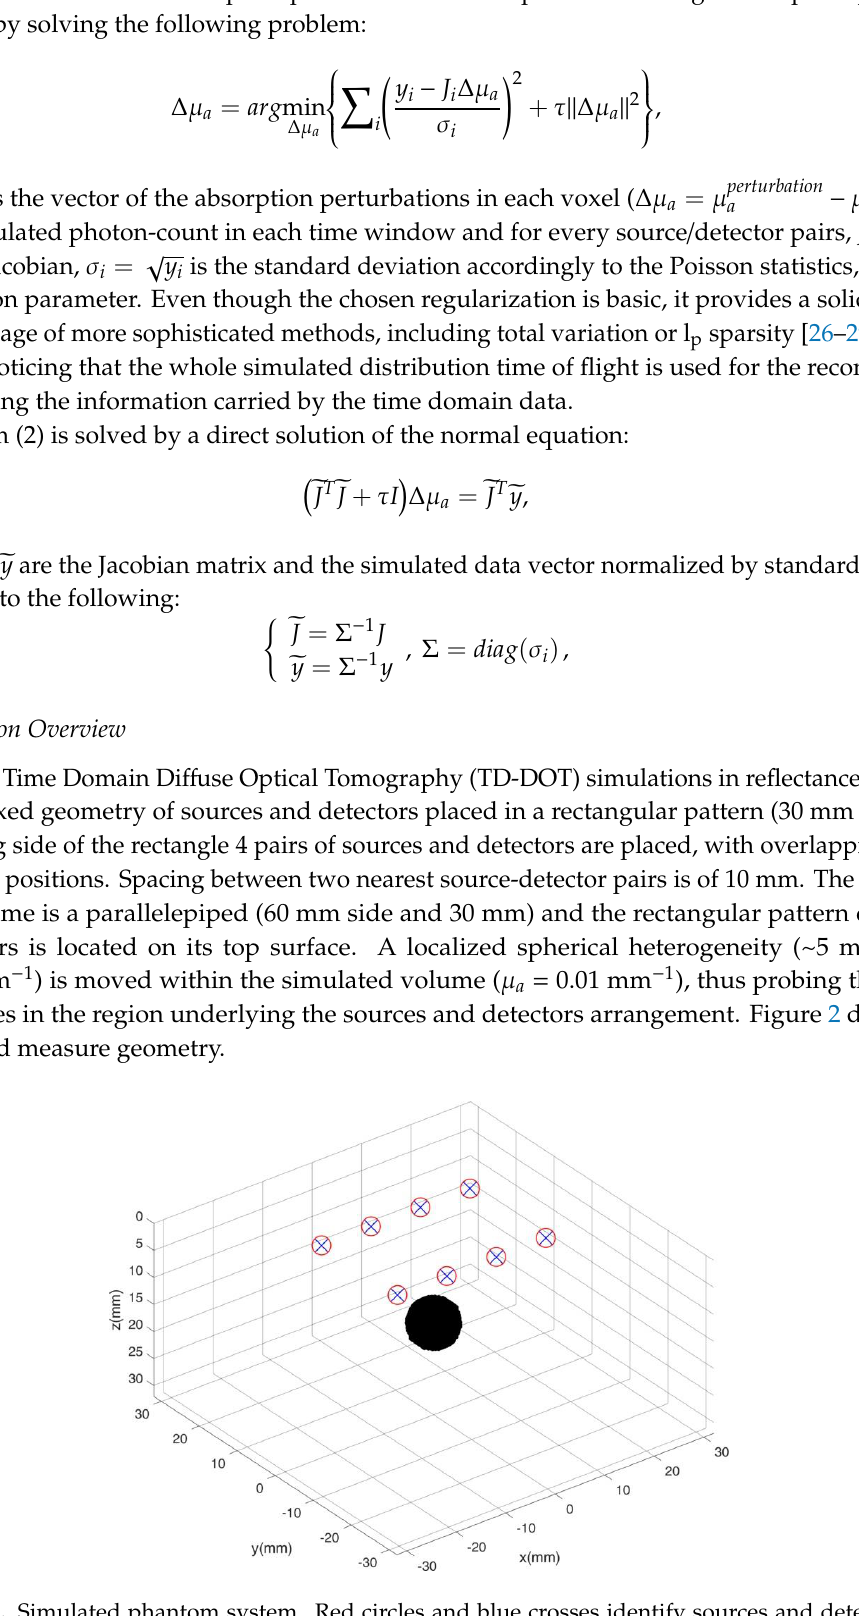
Figure 2. Simulated phantom system. Red circles and blue crosses identify sources and detectors, respectively. The black sphere is the heterogeneity that is moved to probe the entire simulated volume.